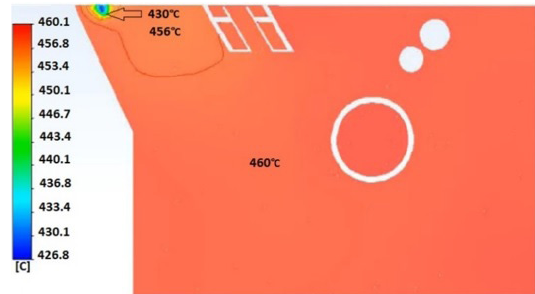
Figure 8. Temperature distribution after complete melting of the ingot inserted into the zinc bath after 7.7min.